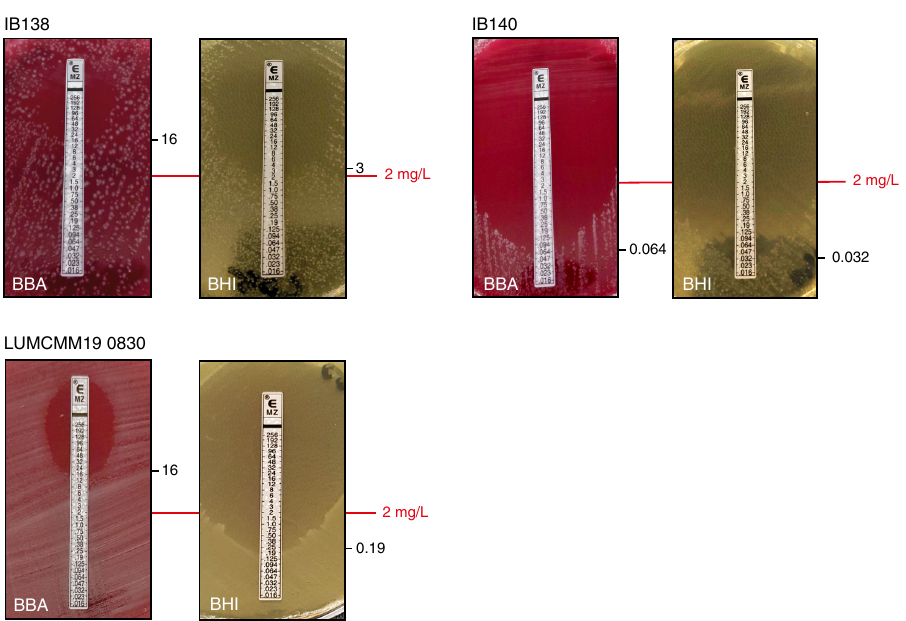
Fig. 4 Medium-dependent metronidazole resistance. Strains were grown as described under antimicrobial susceptibility testing in the Methods section and spread onto either Brucella Blood Agar (BBA) plates, or onto BHIY/CDSS agar plates (BHI). E -tests were placed, and plates were incubated for 48 h before imaging. In all, 2 mg L − 1 is the EUCAST epidemiological cutoff for metronidazole that was used to de fi ne resistance in this study 32 . E -test values for the indicated strains are shown next to their respective panels. The images represent three independent repeats with a single replicate per condition. Source data are provided as a Source Data fi le.